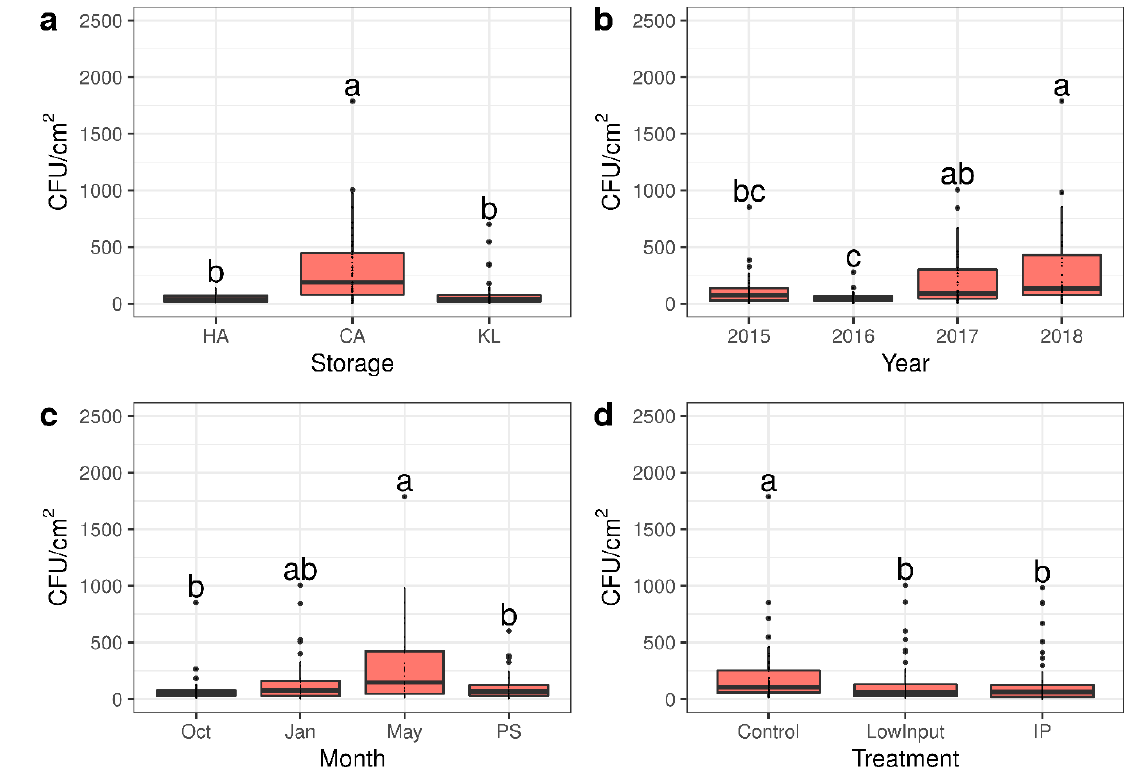
Figure 1. Differences in mesophilic aerobic microorganisms grown on potato dextrose agar (PDA). ( a ) Significantly higher amounts of microorganisms were measured in samples originating from apple skins from controlled atmosphere (CA) storage compared to the HA (harvest sample) and the KL (regular cold storage) samples. ( b ) The growing years showed a significantly higher number of microorganisms for the year 2018 and a significantly lower number of microorganisms for the year 2016 compared to growing years 2015 and 2017. ( c ) During storage, the amount of microorganisms increased before dropping after PS (a shelf-life period of 7 d at 20 °C). ( d ) The untreated control showed higher amounts of microorganisms compared to the low input (no synthetic fungicide after bloom) and the integrated pest management (IP) treatment. Letters denote significance as calculated in Kruskal–Wallis tests with Fisher post hoc tests.